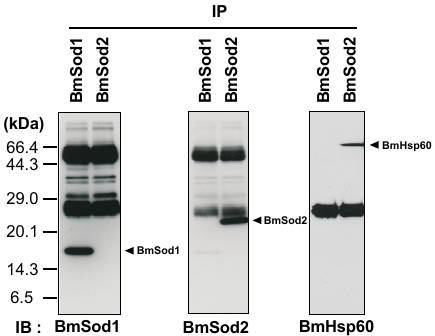
Figure 2. Interaction between BmHsp60 and BmSod2. Results of a co-immunoprecipitation (co-IP) assay. Anti-BmSod1 antiserum and anti-BmSod2 antiserum were used in the co-IP assay. Aliquots (10 µL) after co-IP were separated by 15% SDS-PAGE, transferred to nitrocellulose membranes, and probed with the anti-BmSod1 antiserum, anti-BmSod2 antiserum, or anti-HSP60 antibody. IP; immunoprecipitation, IB; immunoblotting. The predicted molecular weights of BmSod1, BmSod2, and BmHsp60 are 15.8 kDa, 24.2 kDa, and 60 kDa, respectively [21,23]. According to the predicted molecular weights, the black arrows indicate proteins.